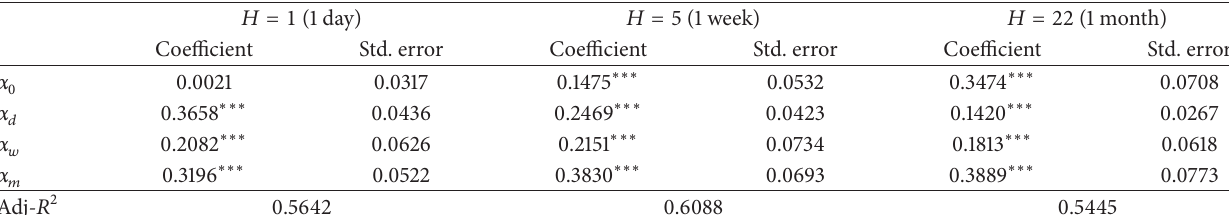
Table 3: Estimation results of the HAR-ARV model.